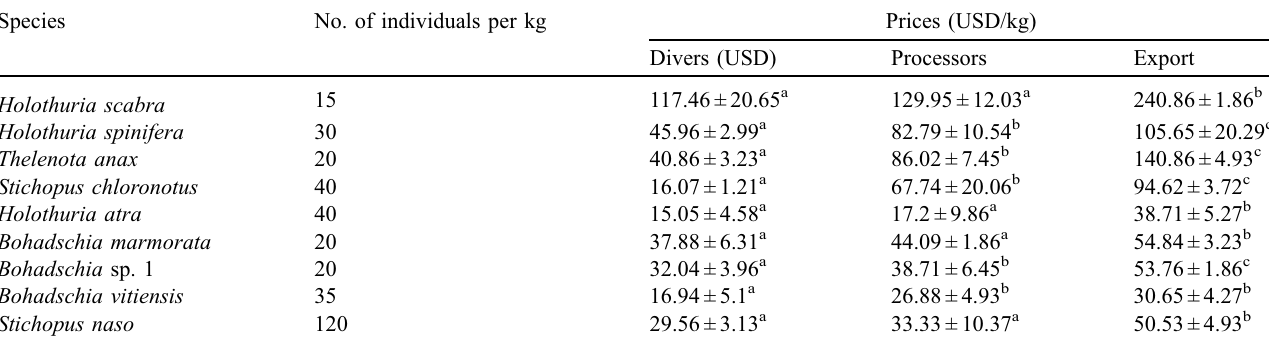
Table 6. Price markup over the value chain of nine sea cucumber species common in the commercial catches of Sri Lanka. Species No. of individuals per